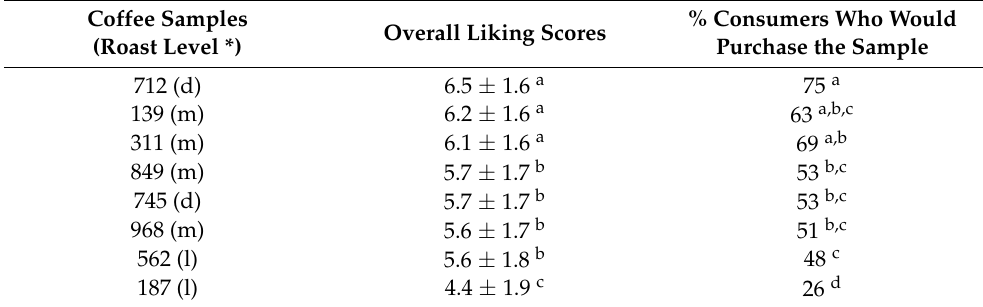
Table 5. Overall liking score and purchase intent of eight black coffee samples, as evaluated by 100